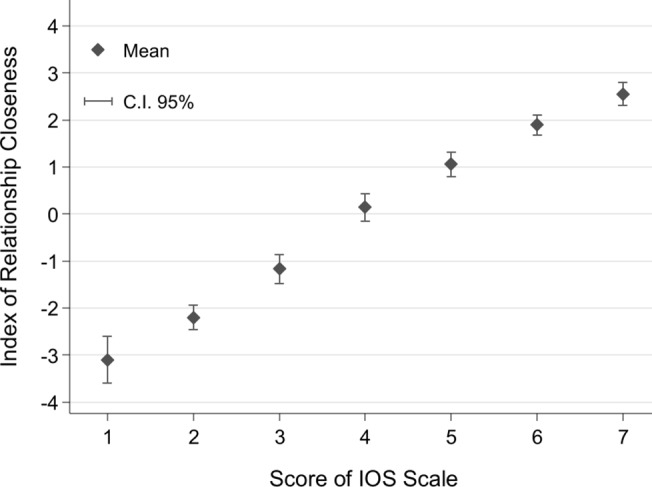
The link between the Index of Relationship Closeness and IOS.‘The Index of Relationship Closeness’ is the principal component of five measurements of the closeness of relationships: RCI and SCI [12], We Scale [22], Loving and Liking Scale [13], and PAM Scale [11].